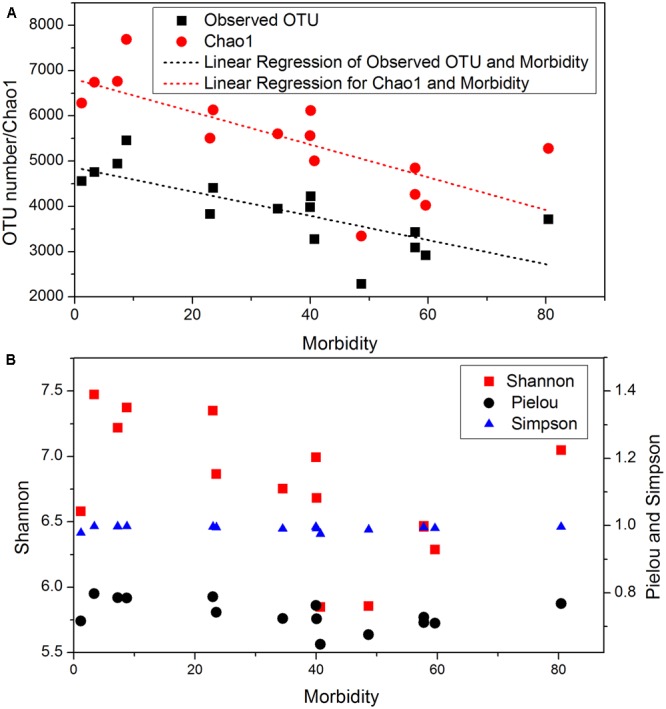
Microbial community diversity in 15 sites with different bacterial wilt infection rate. (A) Observed OTU and Chao1; (B) Shannon, Pielou and Simpson indexes. Linear regressions were present for indexes that significantly (p-value < 0.05) correlated with infection rate (Morbidity). Pearson correlation indexes and p-values are shown in Supplementary Table S5.